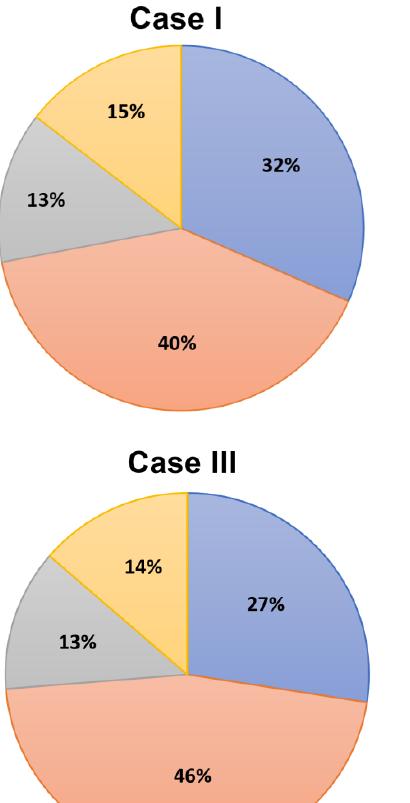
Figure 11. The breakdown of NPV revenue (AUD) over 20 years for the VPP in Case I. Figure 12 shows the scheduling of charging and discharging of the VRFB obtained from the optimization algorithm for a sample day for Case I. Additionally, in this figure, the charging cost and the discharging revenues in AUD for the corresponding hours are presented. As the cost of charging is low during PV generation, in this case, the battery is charged based on the priority given during optimization. In this case, the charging hour priority is 7:00 a.m., 8:00 a.m., 12:00 p.m., and 10:00 a.m. The charging power at 7:00 a.m. and 8:00 a.m. is limited to the excess PV, and that at 12:00 p.m. is limited to the maximum power of the VRFB, which is 350 kW. The discharging is also scheduled based on the output of the optimization. In this case, the discharging occurs to supply the load during the evening, when the RT16 tariff value is high. The algorithm through the optimization looks for the higher WEM prices to discharge the battery during these hours. As shown, the discharge power will supply the load during the hours of 20 to 22, when there is no PV generation. Furthermore, the VRFB is scheduled to discharge at hours of 18 and 19 as the WEM price is high, although there is an excess PV during this time.